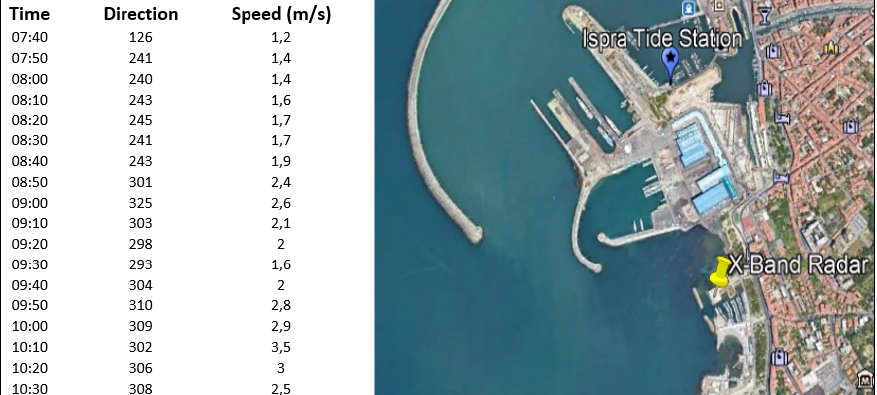
Figure 16. Wind direction and speed measured by the ISPRA tidal weather station in the port of Livorno.